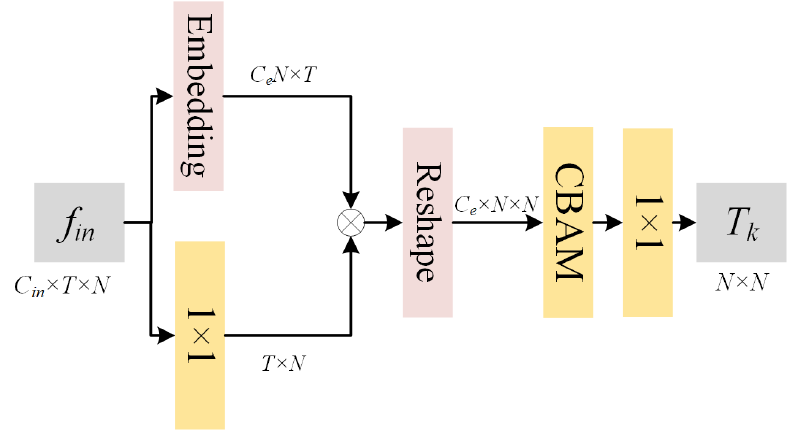
Figure 4. The calculation process of